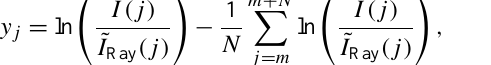
is shown in red and a descending track in blue. The crossing point Fig. 1. OSIRIS often measures the same location twice over the course of 12 h due to orbit. Here an example is the matched pair of scans, 11222020 and 11229004, where the